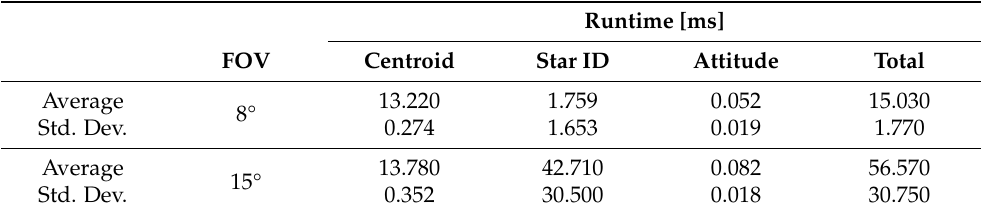
Table 3. Runtime test results (Zynq-7000 ARM Cortex A9MP (ARM v71) SoC @ 667 MHz, sin- gle